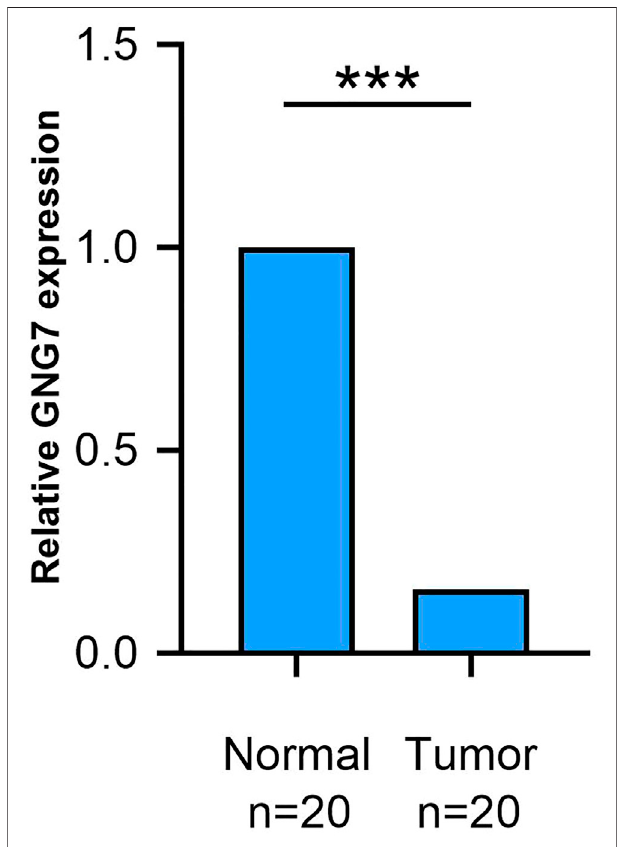
FIGURE5| TheresultsofRT-qPCRexperimentsareconsistentwiththe analysis results of Oncomine and TIMER databases. The expression level of GNG7 mRNA in colorectal cancer tumor tissues is signi fi cantly down- regulatedcompared withnormalpara-canceroustissues.*** p < 0.0001.